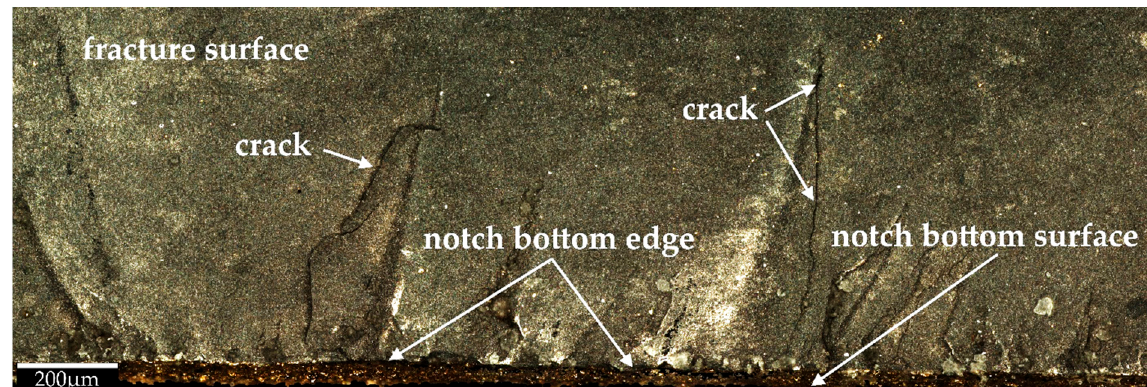
Figure 10. Microscopic view of a fracture surface after impact test with microcracks indicated.